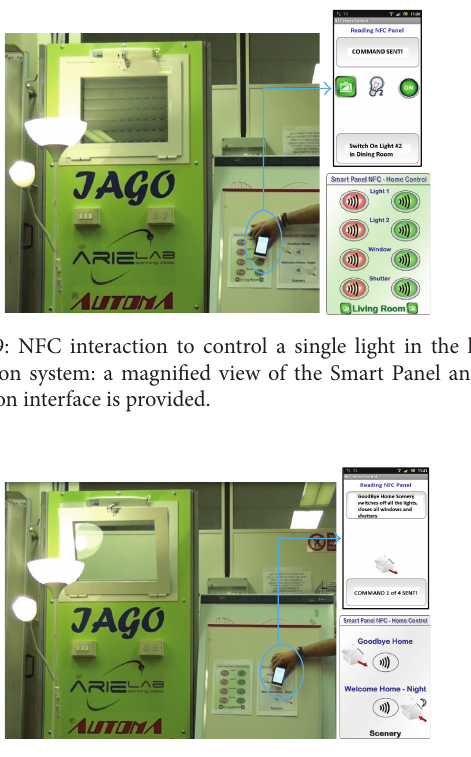
Figure 10: NFC interaction to control several equipment items in the home automation system, by means of a scenario command. A magnified view of the Smart Panel and the application interface is